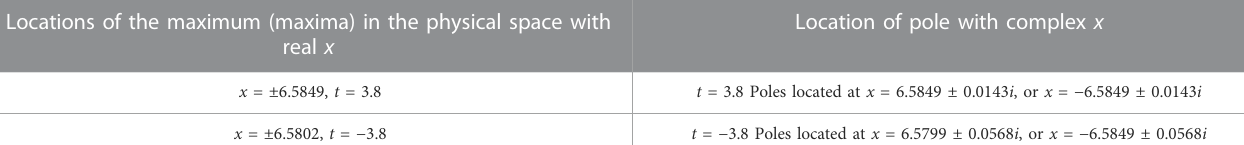
Location of pole with complex x